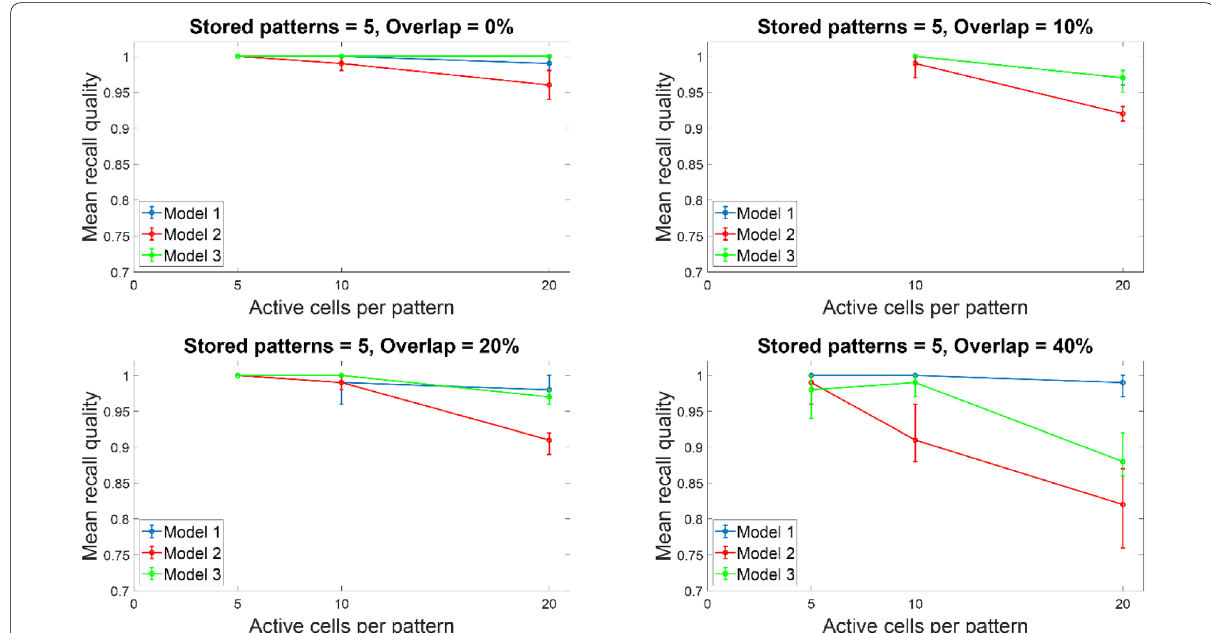
Fig. 12 Mean recall quality of ‘model 1’, ‘model 2’, and ‘model 3’ as a function of active cells per pattern (5, 10, 20) when five patterns were stored with various percentages of pattern overlap. Each model was a network of 300PCs, one BSC, and one OLM